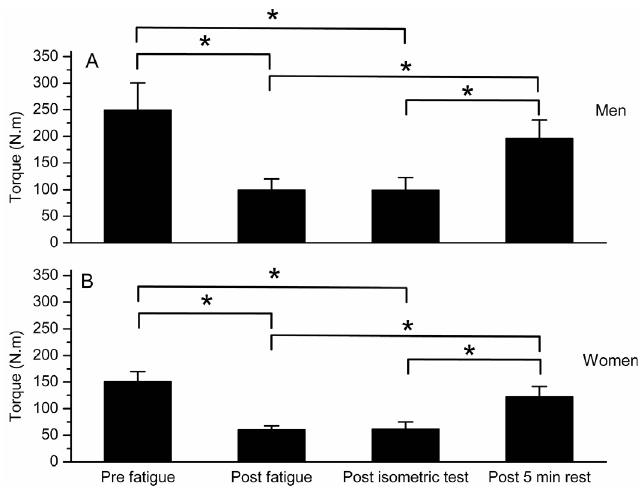
Figure 1 - A) Average and standard deviation of the men fatigue values: pre-fatigue, post-fatigue, pos-isometry and post 5 minutes rest. B) Av- erage and standard deviation of the women fatigue values: pre-fatigue, post-fatigue, post-isometry and post 5 minutes rest. * p (cid:3) 0.05 between